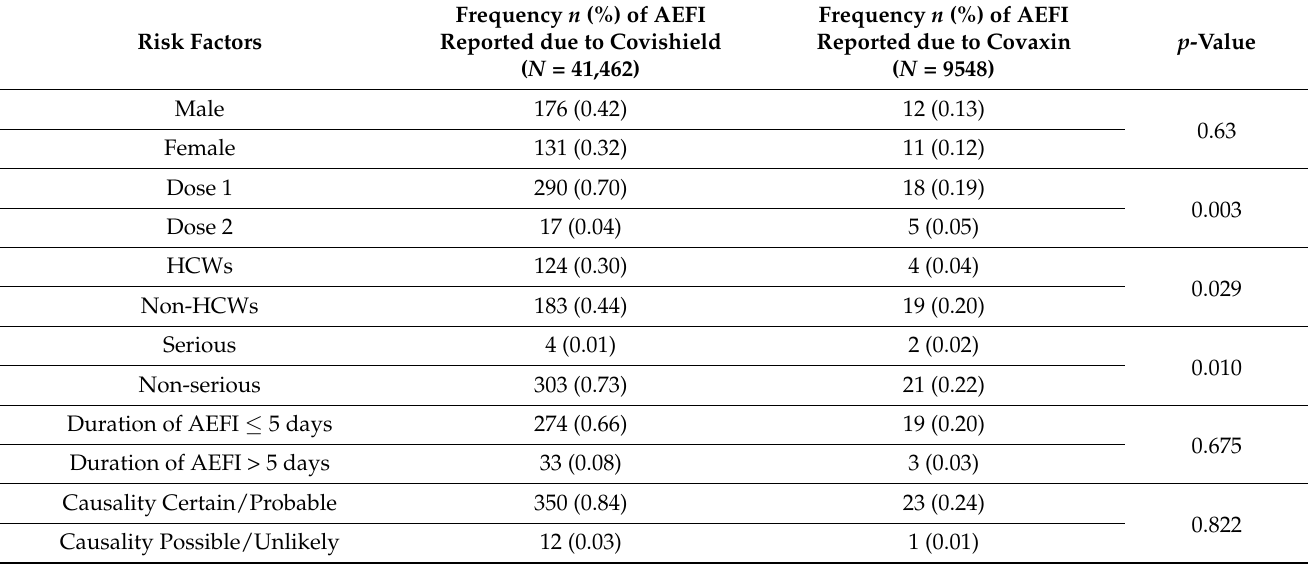
Table 5. Comparison between AEFI due to Covishield and